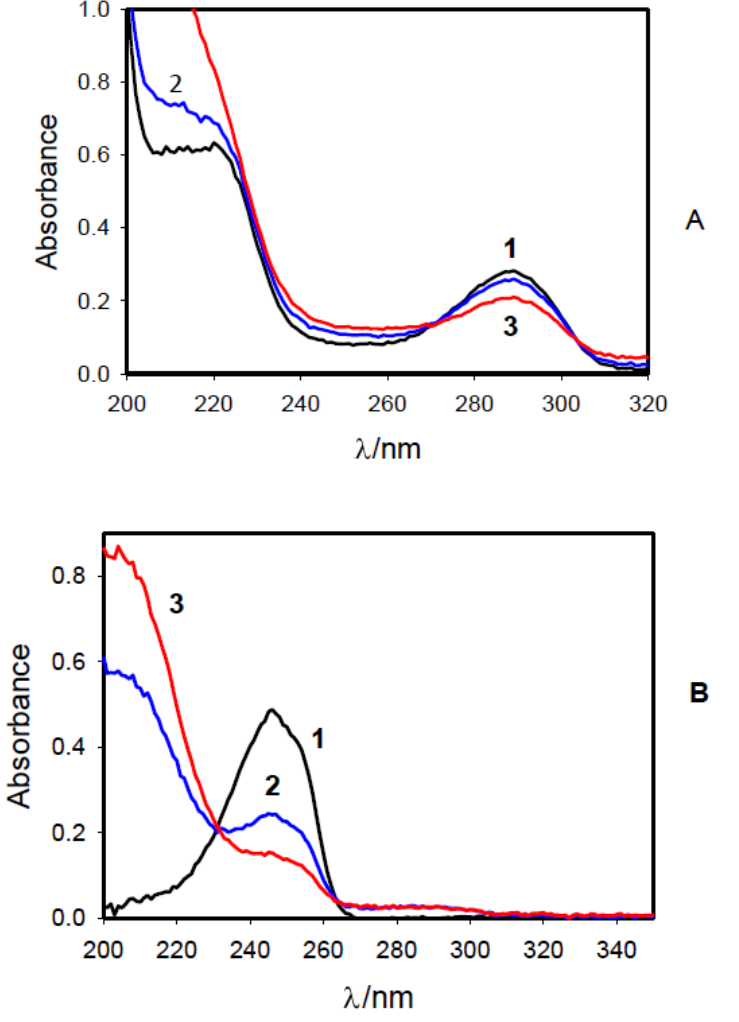
Figure 7. Absorption spectra of 50 µ M 1,4-hydroquinone ( A ) and 1,4-benzoquinone ( B ) aqueous solution before (1) and after treatment with cold atmospheric pressure He-plasma jet for 30 min (2), and 60 min (3). The temperature was 20 °C .